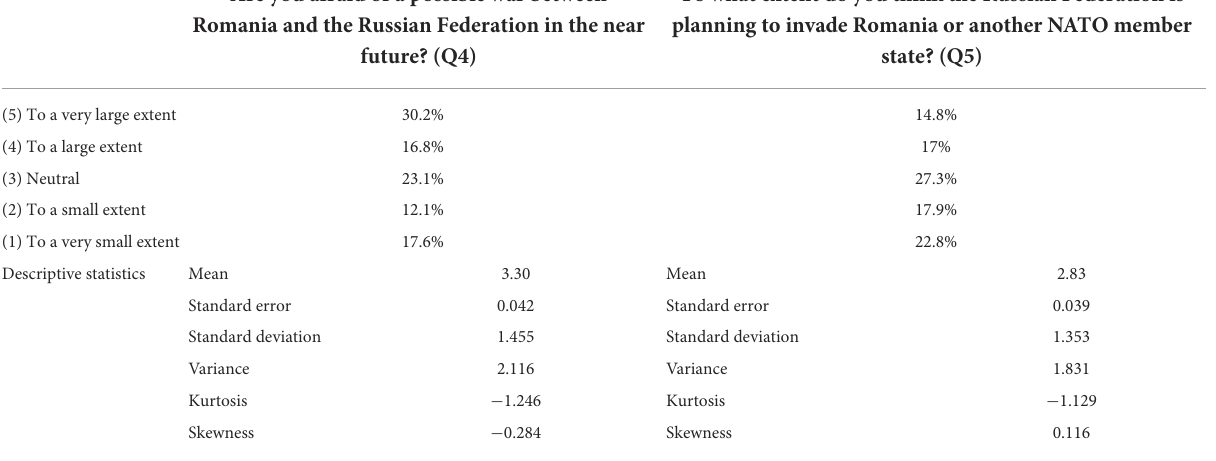
TABLE 4 Participants’ opinion on a possible armed attack by the Russian Federation on Romania or another NATO member state. Are you afraid of a possible war between To what extent do you think the Russian Federation is Romania and the Russian Federation in the near planning to invade Romania or another NATO member future? (Q4) state?